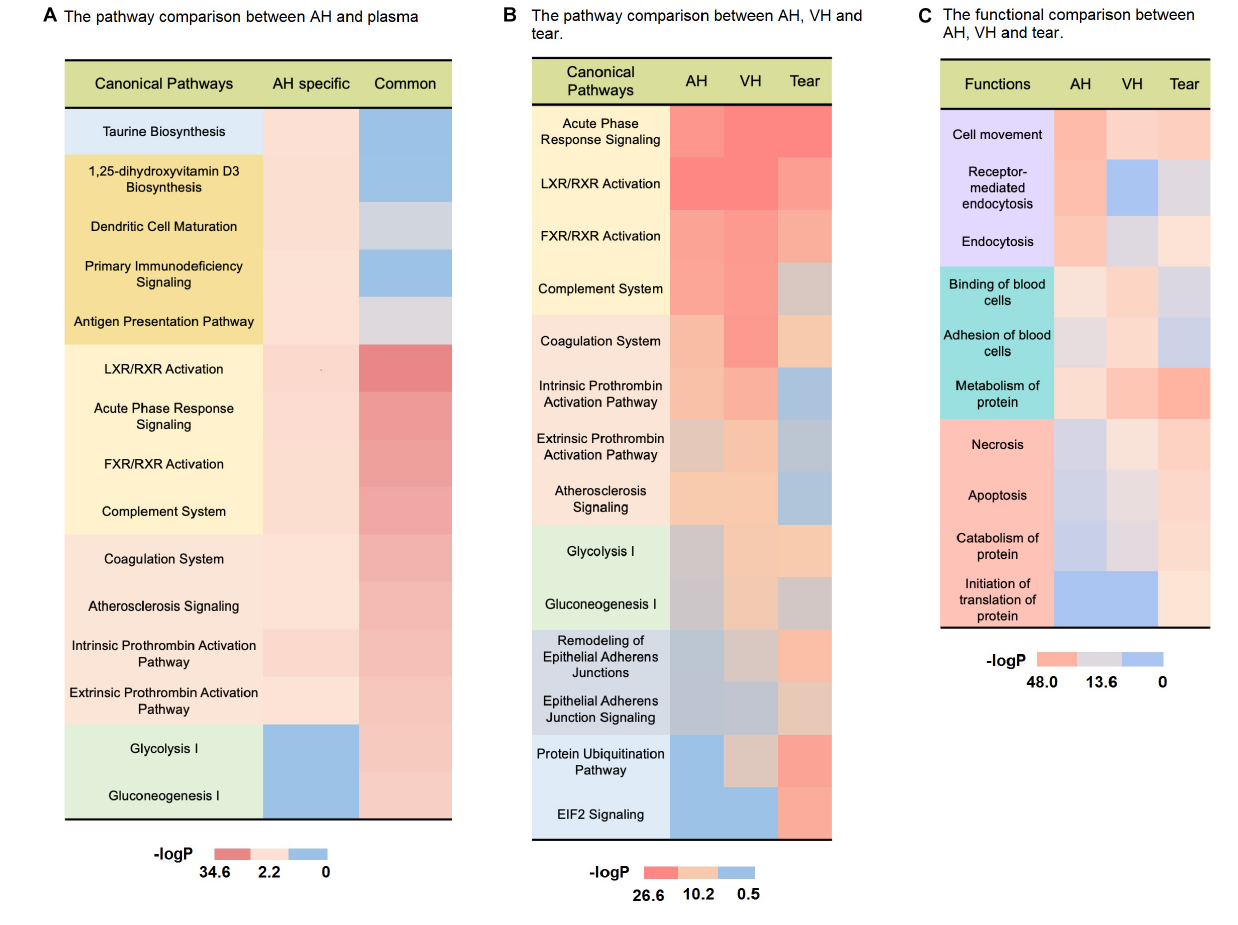
FIGURE 4 | Comparison of the AH and body fluid proteome. (A) The pathway comparison between AH-specific proteins and plasma-derived proteins. (B) The pathway comparison between AH, VH, and tears. (C) The functional comparison between AH, VH, and